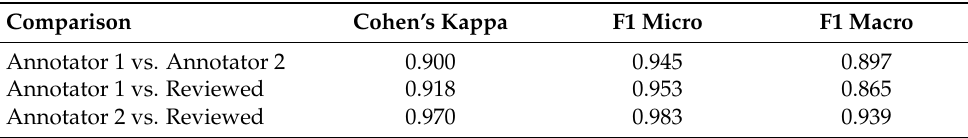
Comparisons between the two medical student annotators (“Annotator 1” and “Annotator 2”) and the final reviewed data (“Reviewed”). We report Cohen’s kappa, F1 micro and F1 macro for 1044 sentences from 138 reports that were annotated by both